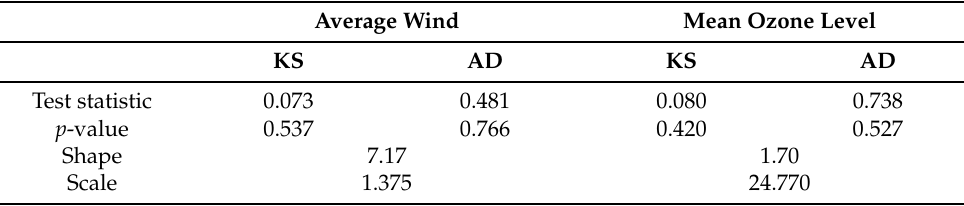
Table 4. KS and AD goodness-of-fit tests for Gamma distribution and MLE